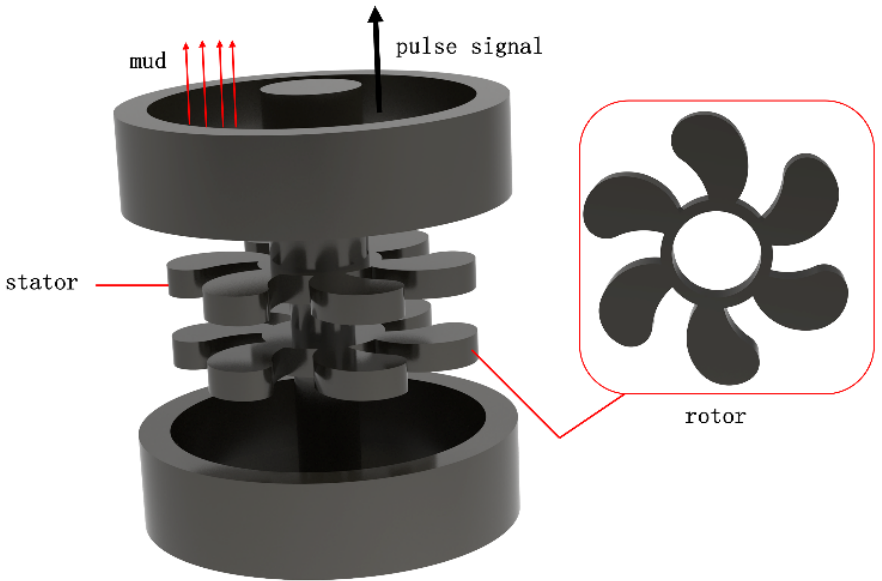
Figure 1. Schematic diagram of MWD pulser and rotor .